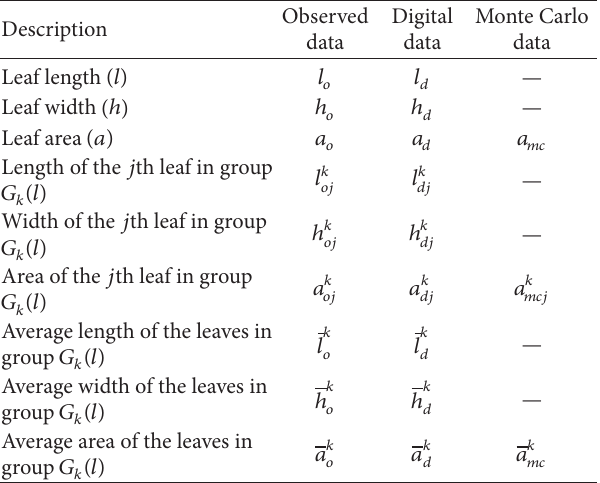
Table 2: Symbols for observed, digitally obtained variables and related